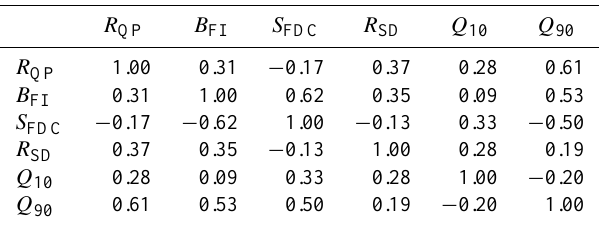
Table 1. Linear correlation values of the six signatures used in this study from the first time